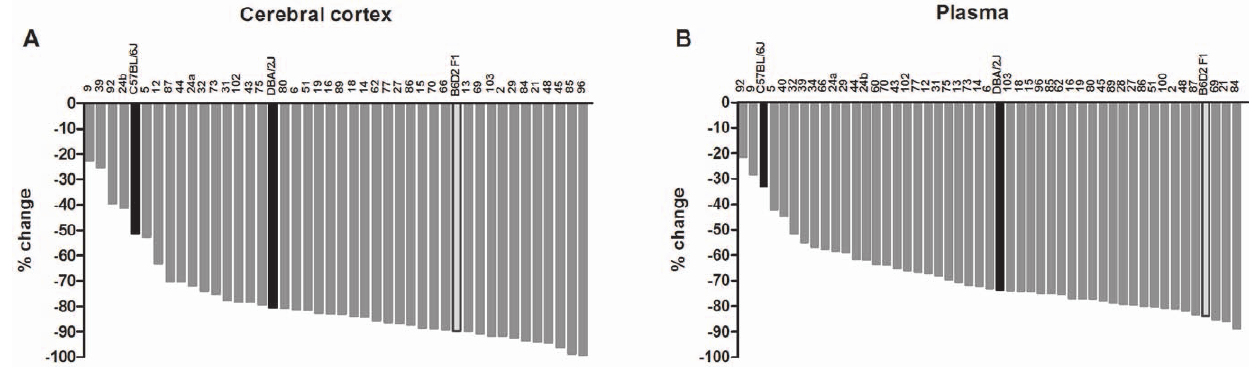
Figure 7. Variation in dexamethasone suppression of DOC levels across the BXD strains. Mice were injected with dexamethasone (0.075 mg/kg, sc) or saline at 8:00 am and were sacrificed 6 hours later. Data are expressed as % change of the average for dexamethasone-treated mice vs. the average for the respective saline-treated mice ( n =2–9/group/strain). The x axis reports the BXD strain number; C57BL/6J (B6), DBA/2J (D2) and B6D2 F1 hybrid are also indicated. Strains are plotted in order from the lowest to the highest suppression of DOC levels for cerebral cortex (42 BXD strains) or plasma (47 BXD strains), respectively.